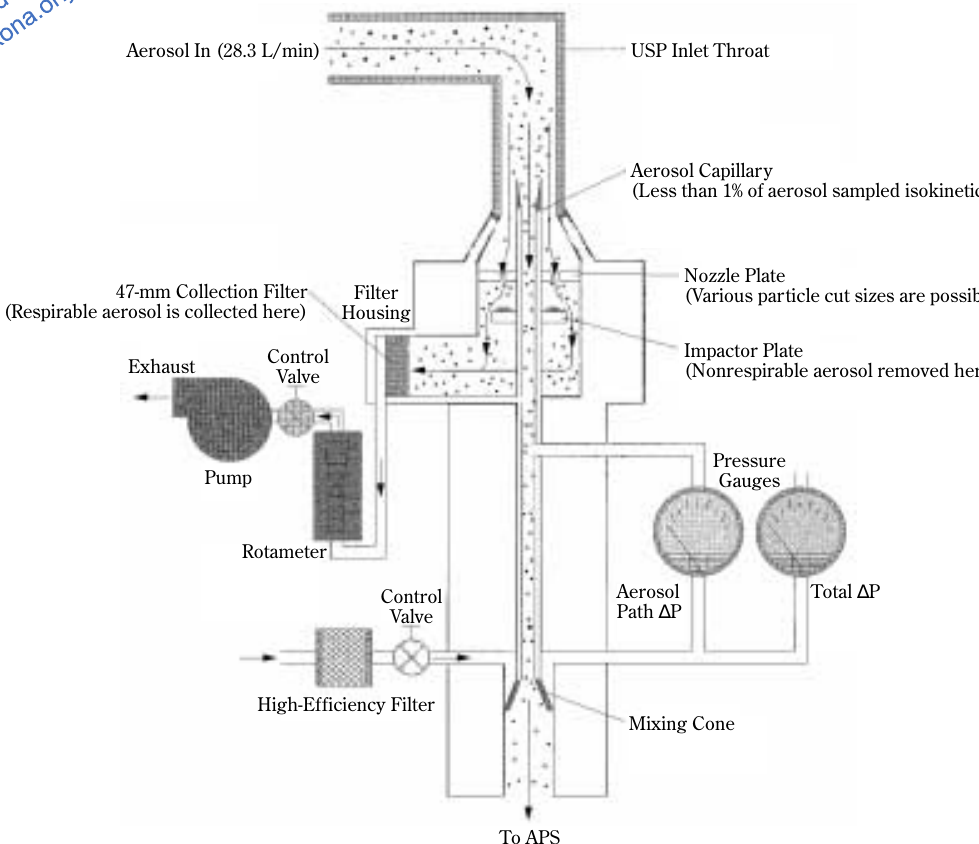
Fig. 9 Model 3306 single stage impactor for use with the APS ® aerodynamic particle sizer spectrometer for the size characterization of med- ical aerosols (courtesy TSI Inc.)